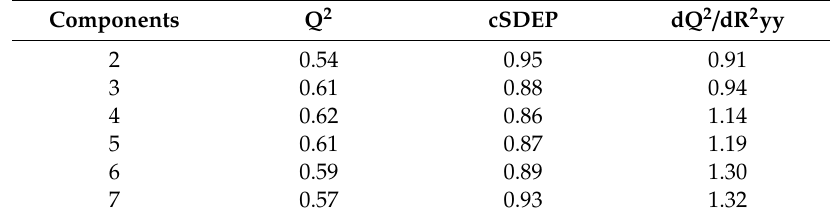
Table1. Progressivescramblingtestresultsforthecomparativemolecularfieldanalysis(CoMFA)model.